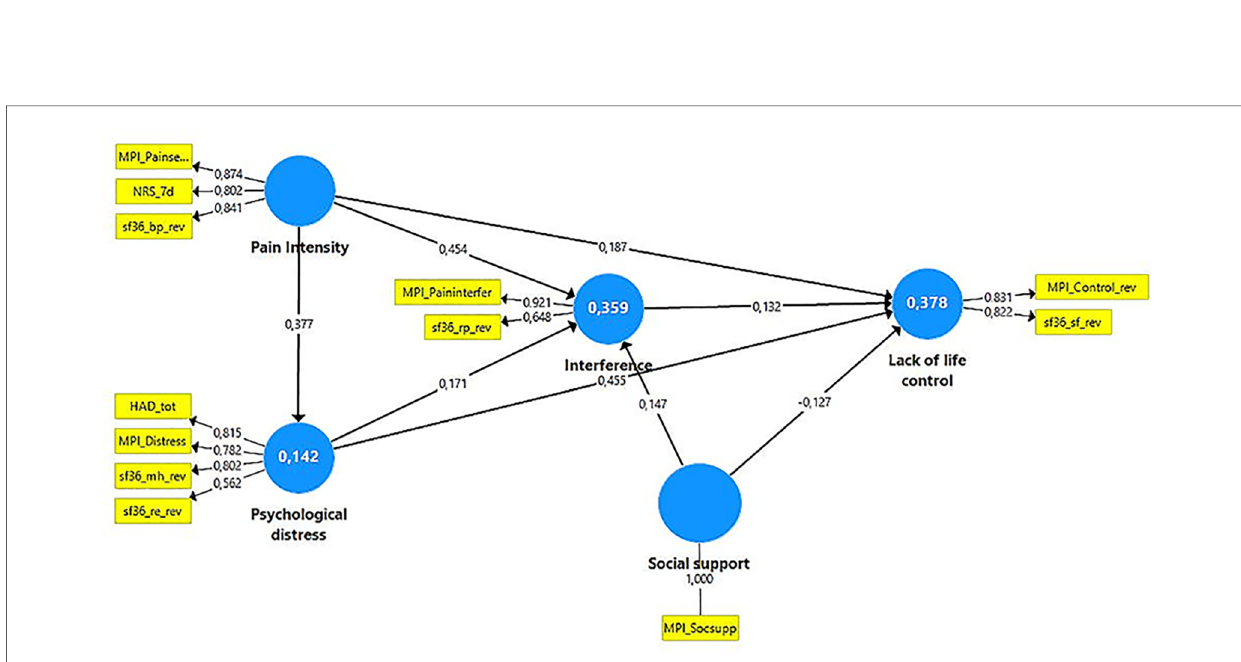
FIGURE 5 Model 2 (pain intensity affects psychological distress) for the subgroup with high distress ( N =19,288). The blue circles show the constructs. The yellow boxes show the indicators (re fl ective) for each latent variable; the fi gure attached to the thin arrows show the loading. The thicker arrows show the suggested relations between the constructs. The fi gure attached shows the path coef fi cient (direct effect). The explained variance ( R 2 ) is reported within the relevant constructs. Note that some of the MPI variables and all sf36 variables were revised (indicated with _rev in the variable name) so that high values indicated a troublesome/negative situation. NRS_7d, Pain intensity according to a numeric rating scale; HAD, The Hospital Anxiety and Depression Scale; HAD-tot, sum of the two subscales of HAD; MPI, Multidimensional Pain Inventory; MPI_Paininterfer, MPI Pain interference; MPI_Painseverity, MPI Pain severity; MPI_Socsupp, MPI Social support; sf36, The Short Form Health Survey; sf36_rp, sf36-role physical; sf36_bp, sf36- bodily pain; sf36_sf, sf36-social function; sf36_re, sf36-role emotional; sf36_mh, sf36-mental